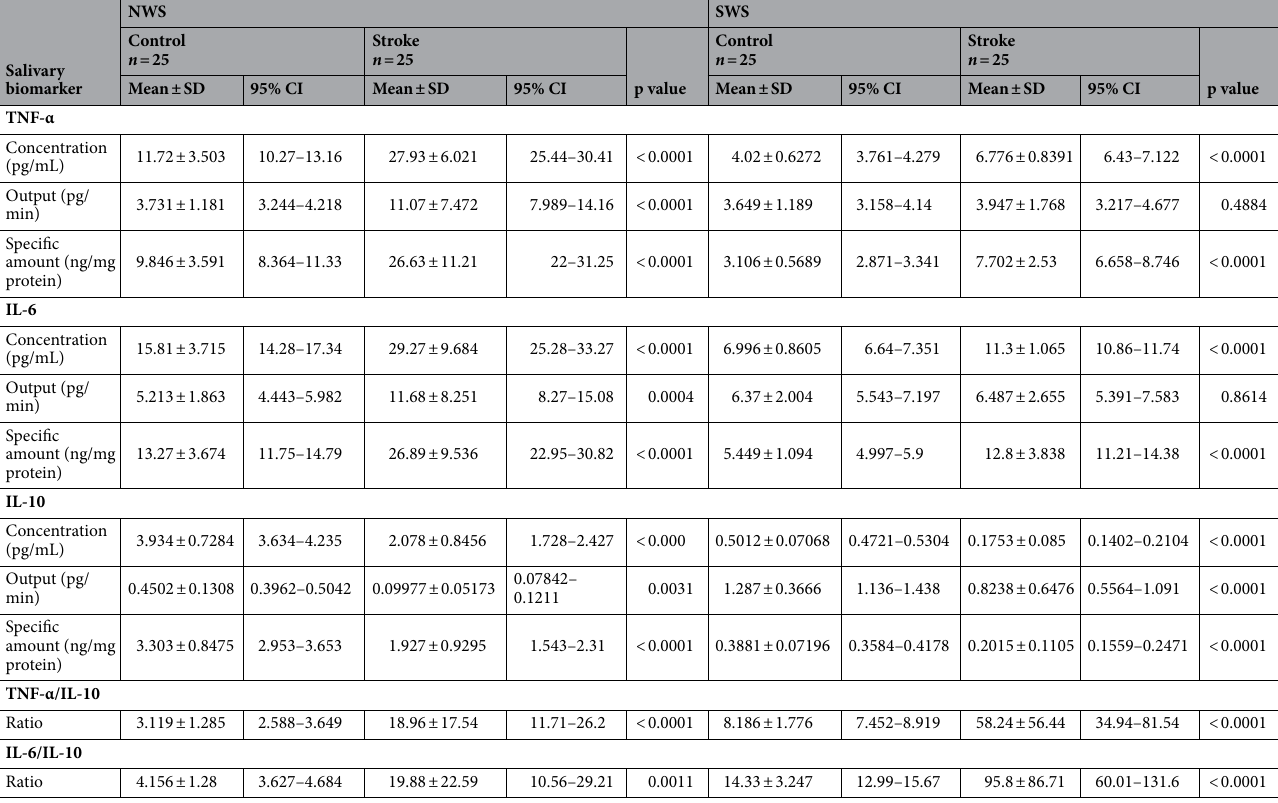
Table 4. Salivary cytokines in stroke patients and healthy controls. TNF-α tumor necrosis factor α, IL-6 interleukin 6, IL-10 interleukin 10.